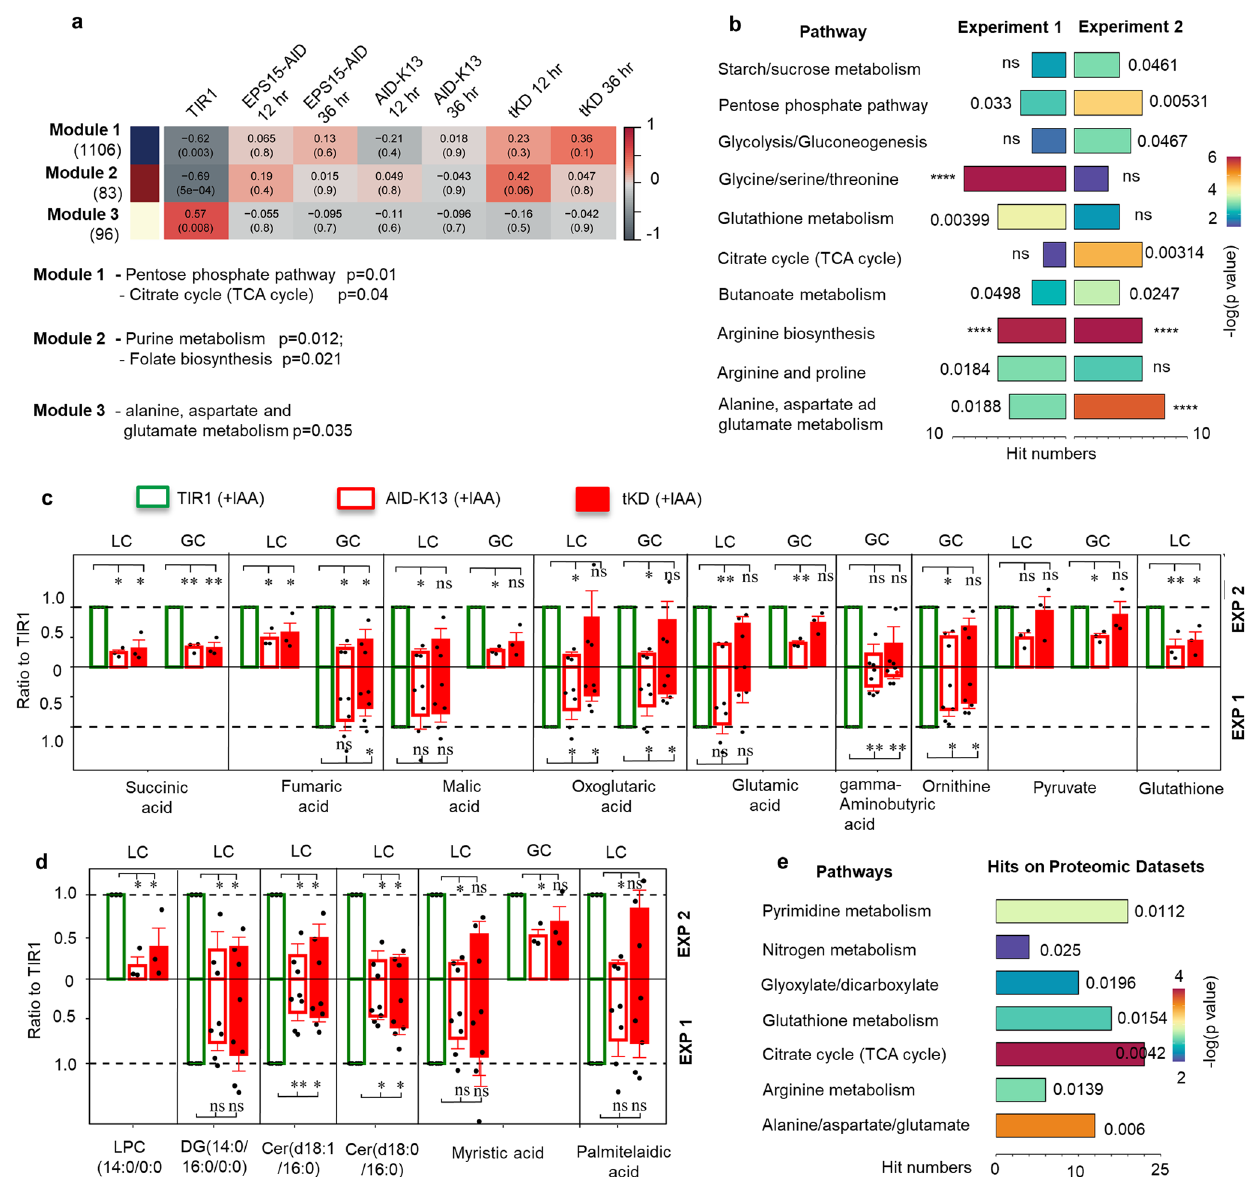
Fig. 4 | The micropore proteins are associated with metabolic pathways. a Expression pattern analysis on T. gondii mRNA transcripts generated with +IAA induced lines. The WGCNA analysis identi fi ed characteristic modules with high or low expression of genes in TIR1, which re fl ected overall changes in the AID